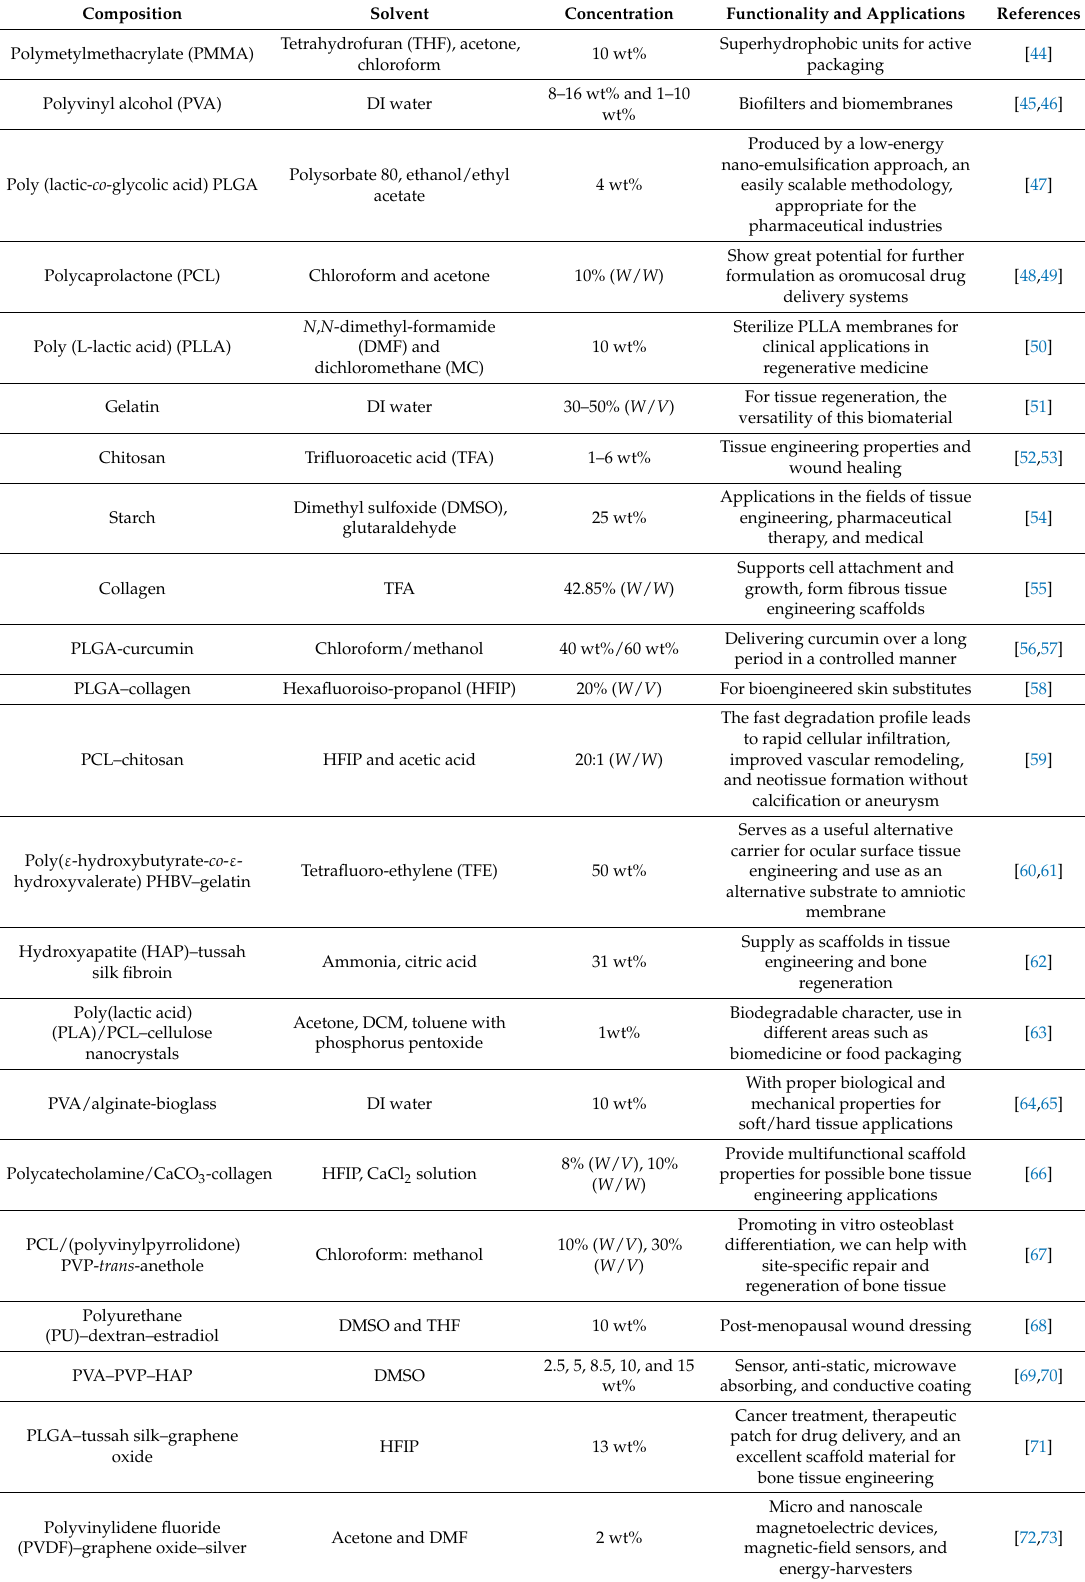
Table 2. Composition, solvent, concentration, and functionality and applications of polymer fibers.